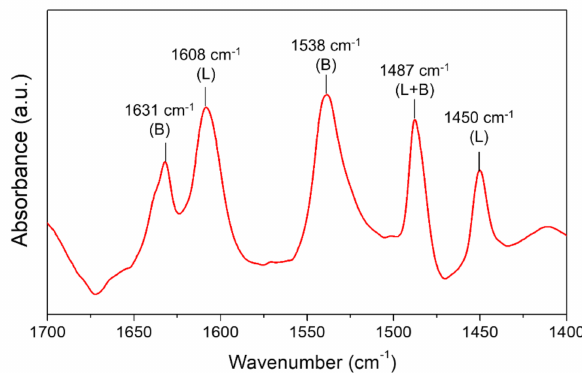
Figure 3. FT-IR spectra of pyridine absorbed on ReO x NPs after pyridine absorption and desorption of physisorbed pyridine. L: Lewis bonded pyridine. B: Brønsted bonded